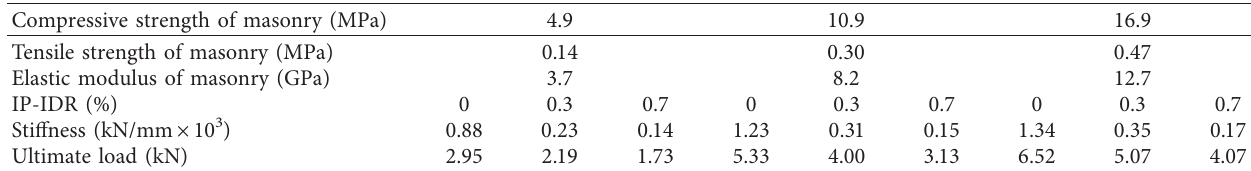
Figure 8: OOP load-displacement curves of infill walls with different slenderness ratios. (a) Without IP damage. (b) With IP damage (IDR � 0.3%). (c) With IP damage (IDR � 0.7%). Table 6: The information and analysis results of infill walls with different masonry